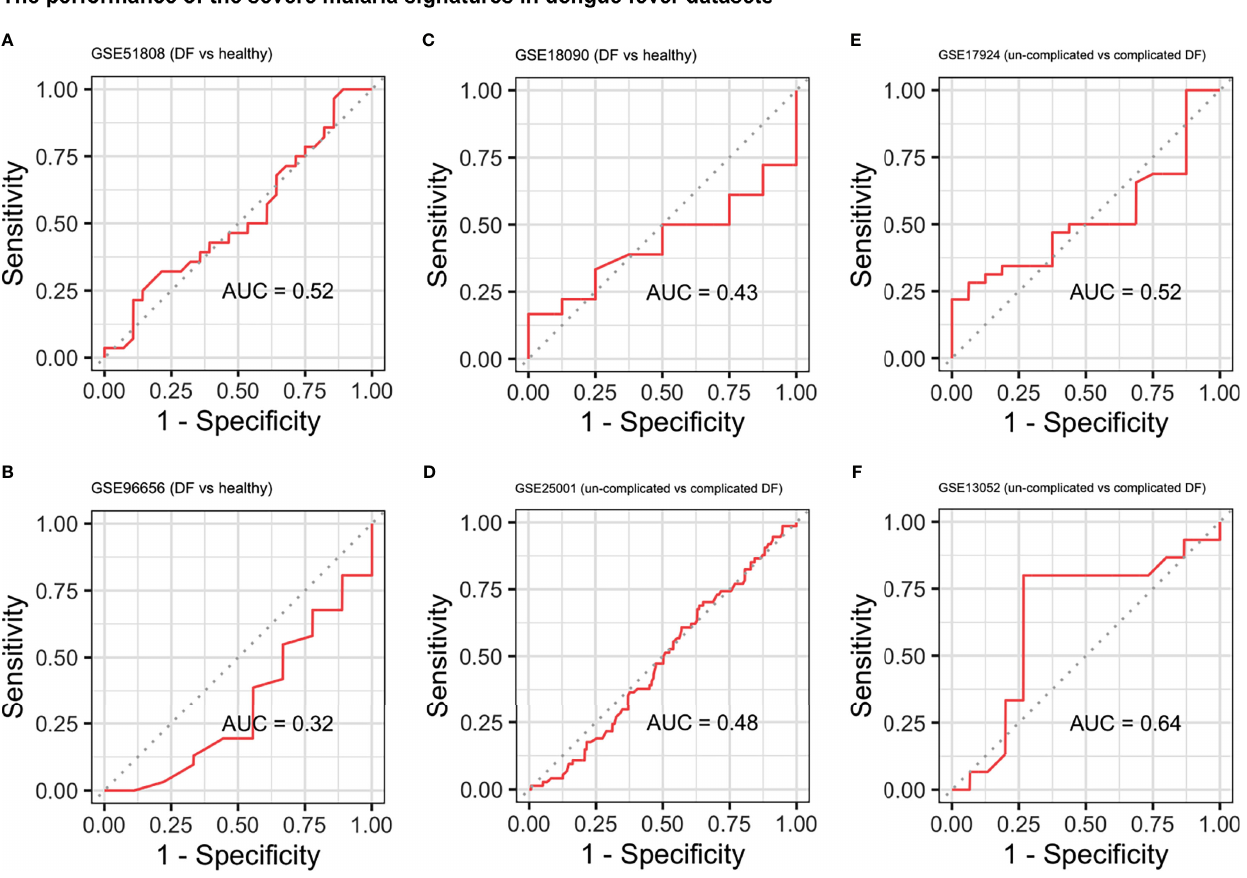
FIGURE 3 | Performance of the severe malaria signature in the dengue fever datasets. ROC curves showing the performance of the severe malaria signature at distinguishing DF from healthy controls (A – C) and uncomplicated DF from complicated DF (dengue hemorrhagic fever and dengue shock syndrome) (D – F) . DF, Dengue fever; AUC, area under the ROC